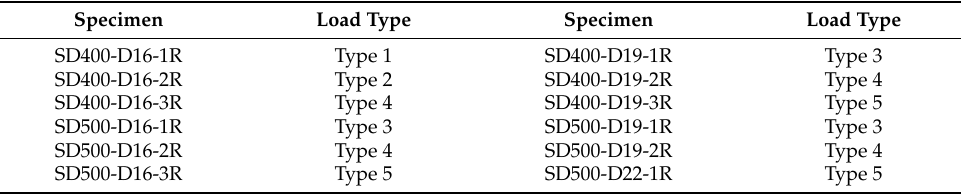
Table 9. Repeated loading types for test